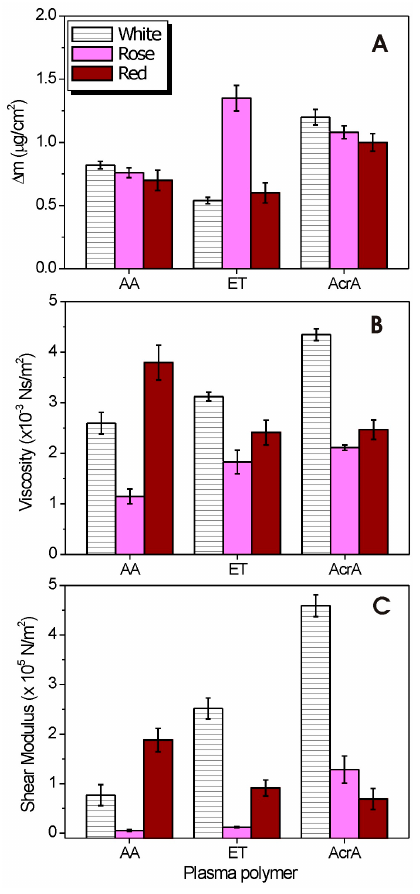
Figure 5. ( A ) Mass changes; ( B ) viscosity changes; and ( C ) shear elastic modulus of various wine samples on the pp surfaces estimated from the Voigt model.